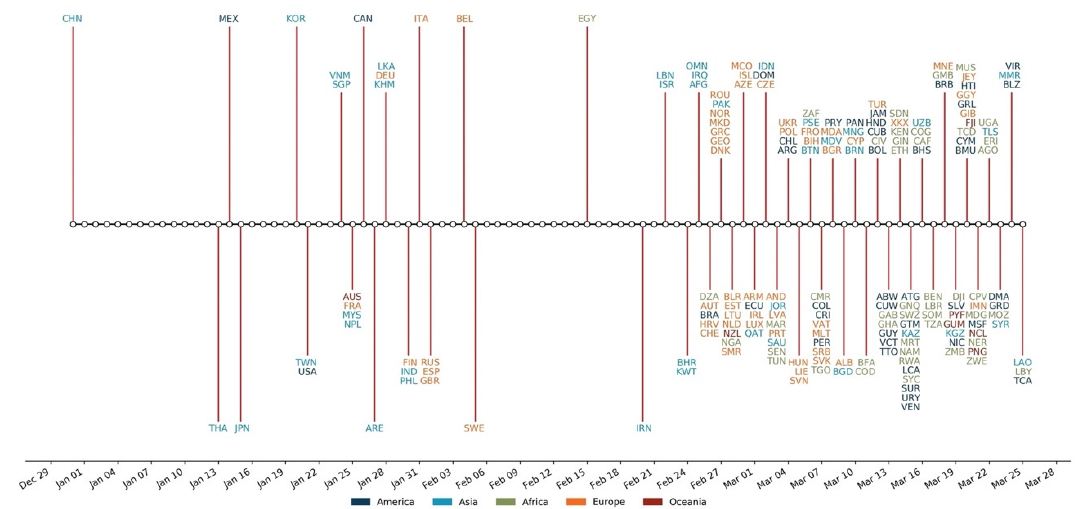
Figure 4. Timeline of first case reporting by country (due to space constraints, countries’ names are shown in ISO 3166 alpha 3 codes).